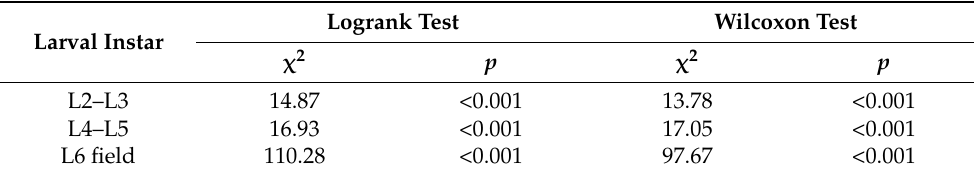
Table 4. Statistics of the analysis comparing the survival probability of the larvae of different ages treated with the control solution with the survival probability of the larvae treated with the Beauveria bassiana solution.